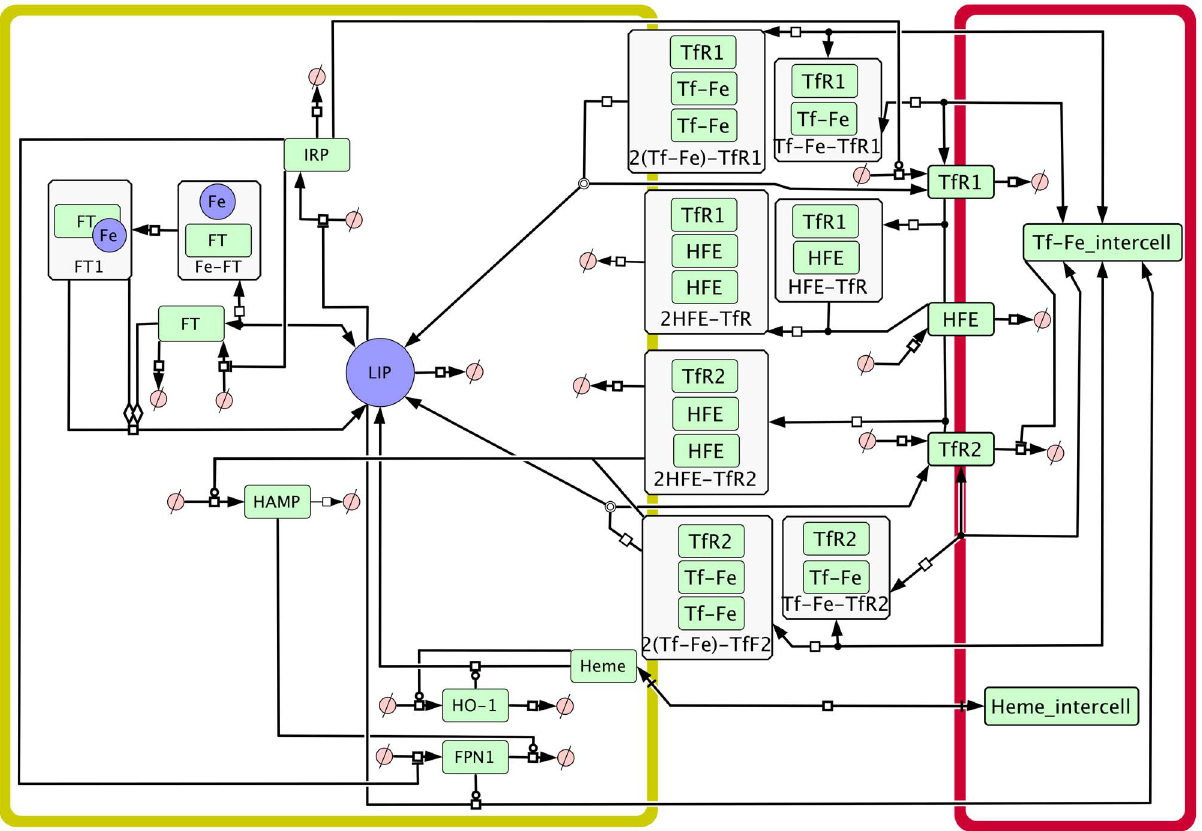
Figure 1. SBGN process diagram of human liver iron metabolism model. The compartment with yellow boundary represents the hepatocyte, while the compartment with pink boundary represents plasma. Species overlayed on the compartment boundaries represent membrane-associated species. Abbreviations: Fe: iron, FPN1: ferroportin, FT: ferritin, HAMP: hepcidin, haeme: intracellular haeme, haeme_intercell: plasma haeme, HFE: human haemochromatosis protein, HO-1: haeme oxygenase 1, IRP: iron response protein, LIP: labile iron pool, Tf-Fe_intercell: plasma transferrin-bound iron, TfR1: transferrin receptor 1, TfR2: transferrin receptor 2. Complexes are represented in boxes with the component species. In the special case of the ferritin-iron complex symbol, the amounts of each species are not in stoichiometric amounts (since there are thousands of iron ions per ferritin).